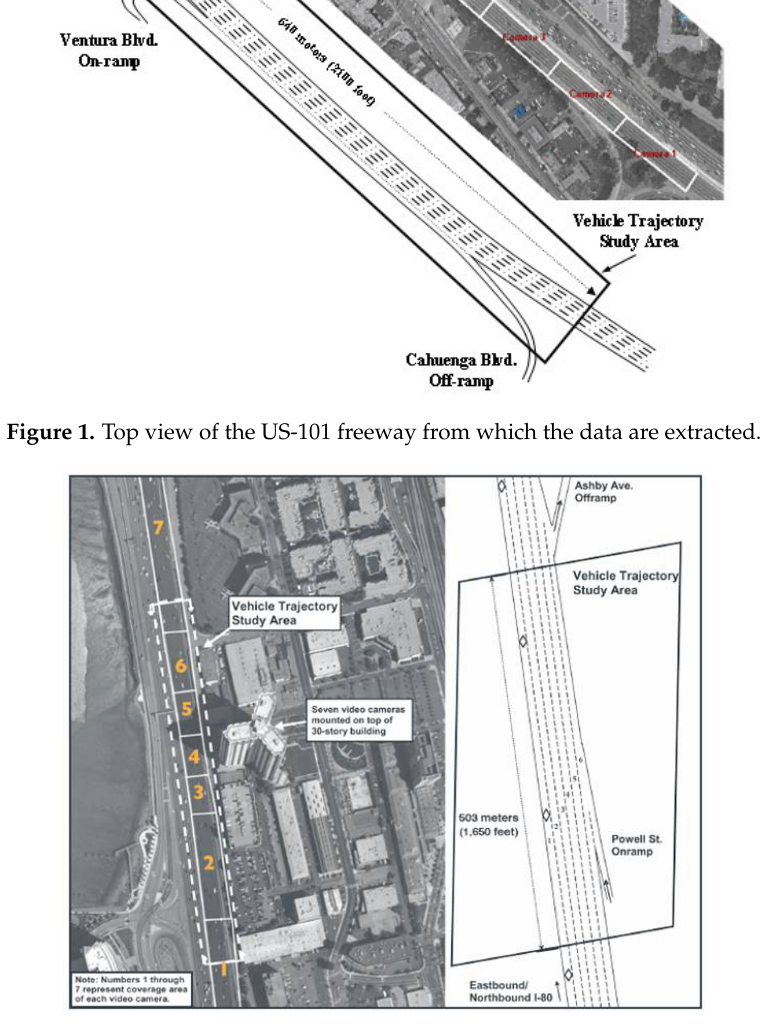
Figure 2. Top view of the I-80 freeway from which the data are